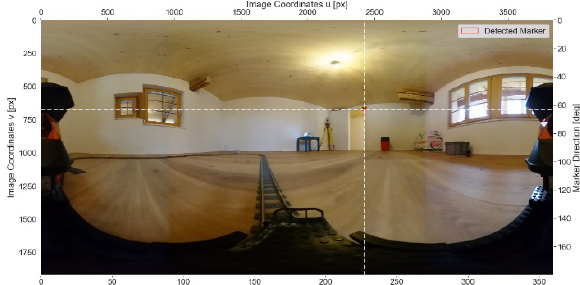
Figure 5. Horizontal and vertical direction of detected marker used for direction calculation in equirectangular camera frame 4.3.6 Calculation of possible Camera Locations: The possible camera locations can be calculated using the horizontal direction of the marker, the horizontal distance between 360° prism and camera and the position of marker and 360° prism (Figure 6).